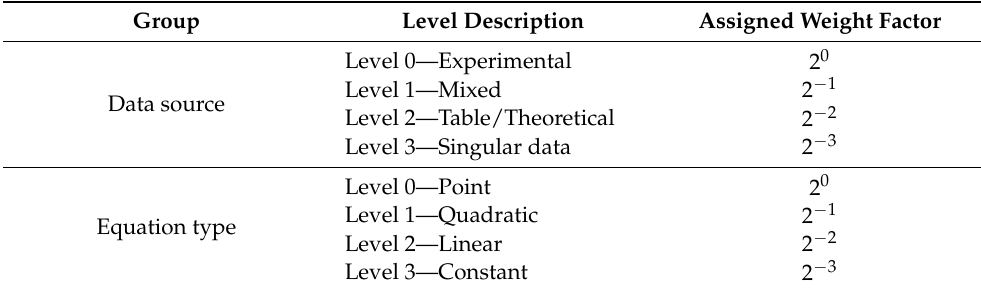
Table 2. Suggested weight factor for data